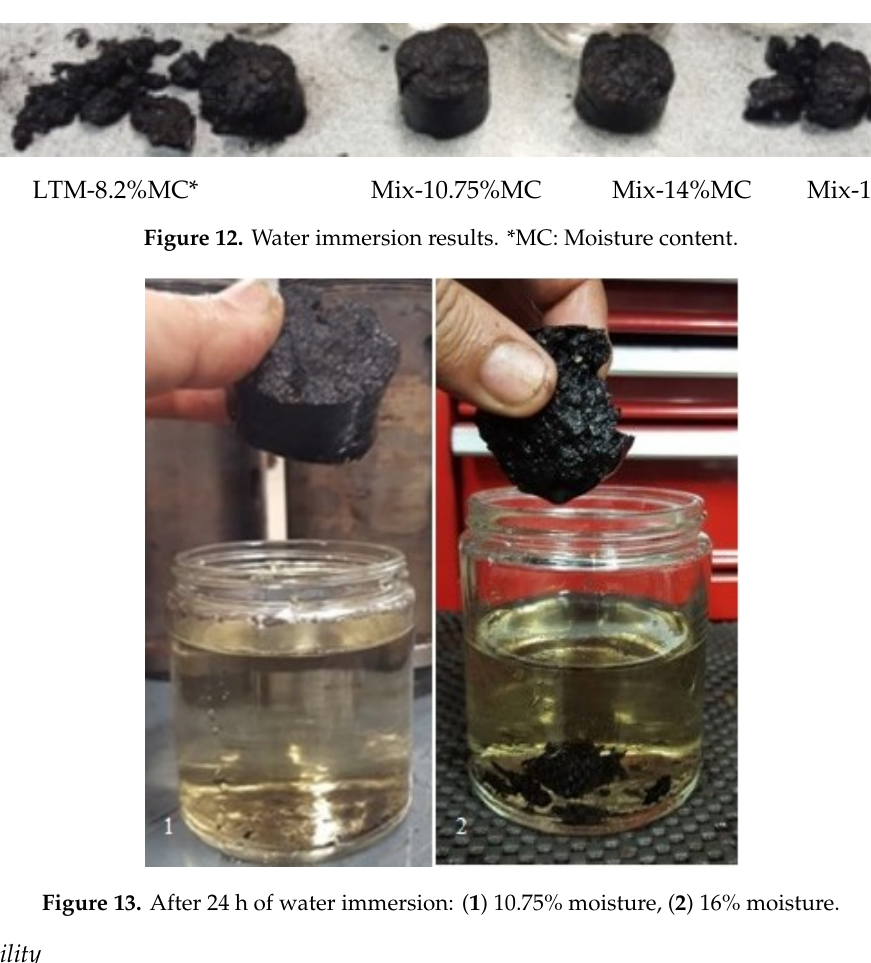
Figure 11. Water gain after immersion vs. feed moisture content for two test periods.